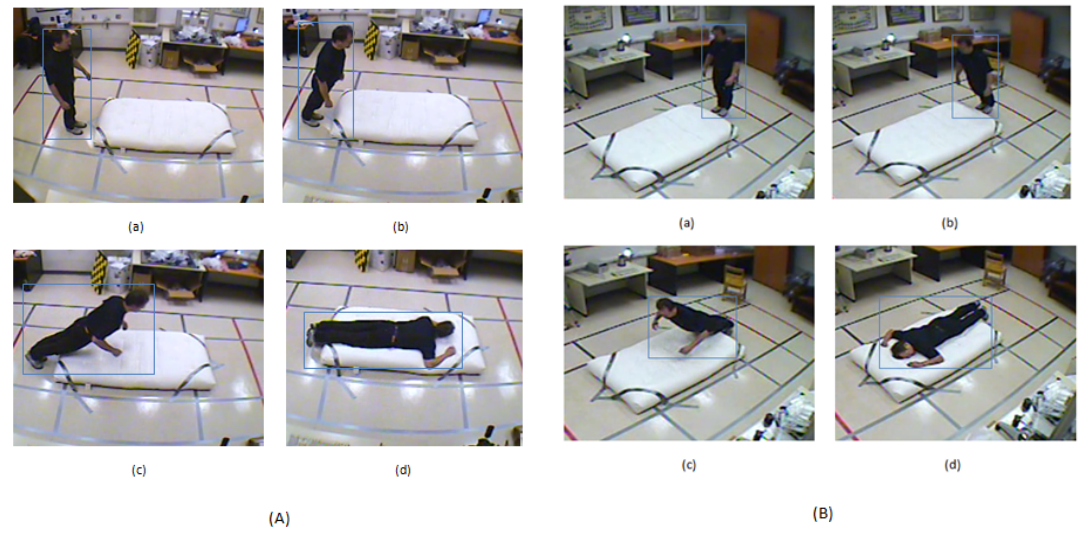
Figure 1. Temporal variation of the aspect ratio ( a r ) of a falling person in the Multiple Camera Fall (MCF) dataset where a r = width/height of bounding box of a foreground blob. The person angle ( p a ), shape deformation ( s d ), and ellipse ratios ( e r ) are also shown for each case. ( A ) Camera 7, video